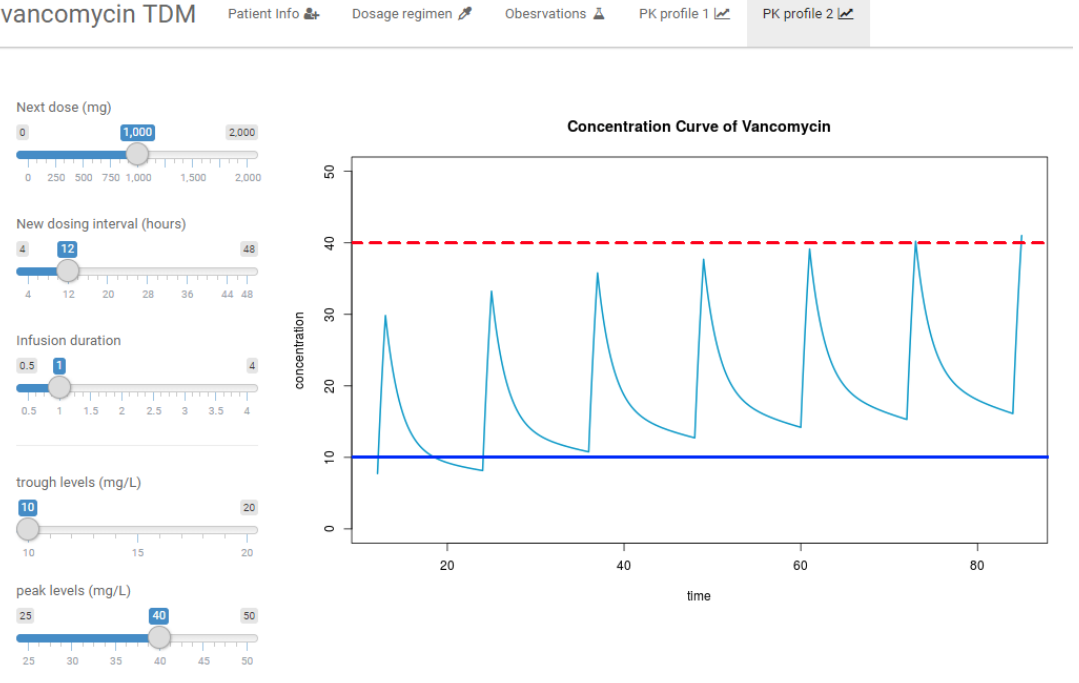
Figure 4. User interface of the open-source vancomycin therapeutic drug management software.